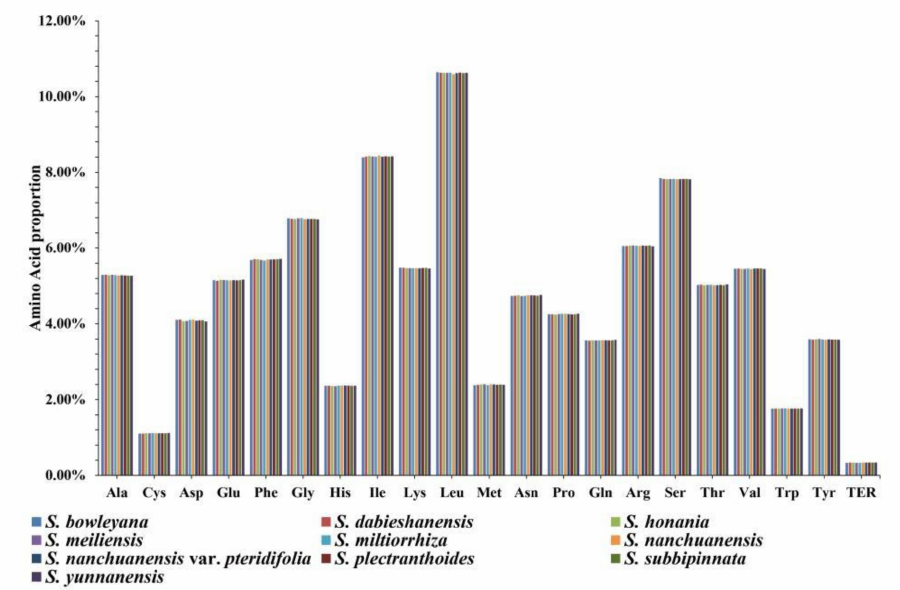
Figure 2. Amino acid frequencies in all protein-coding genes in the chloroplast genome of 10 taxa of Salvia sect. Drymosphace .